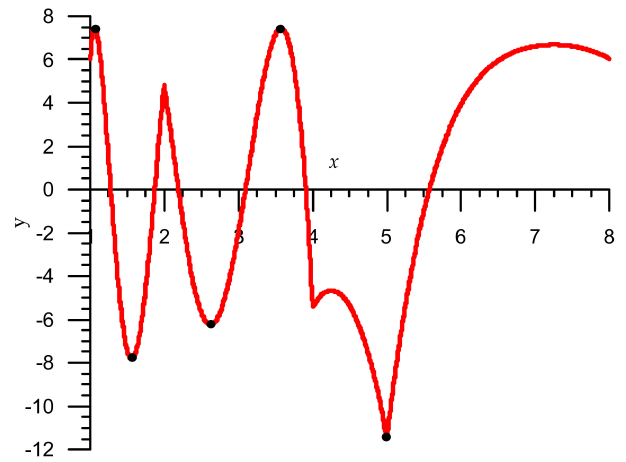
Figure 2. The first iteration relative error graphs Algorithm 3 for the interval x ∈